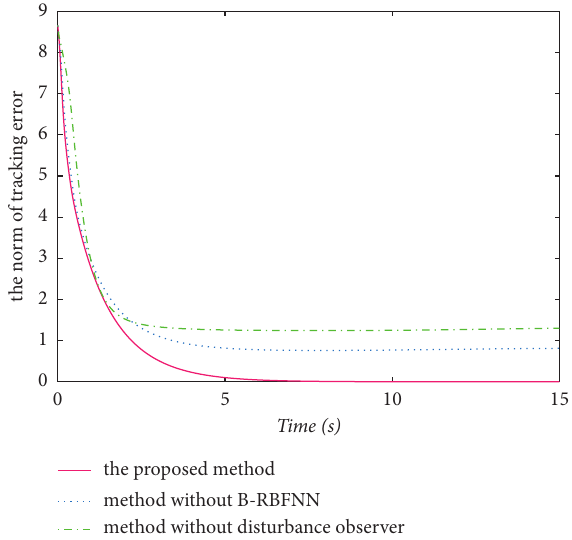
Figure 10: Trajectory of tracking errors of different control